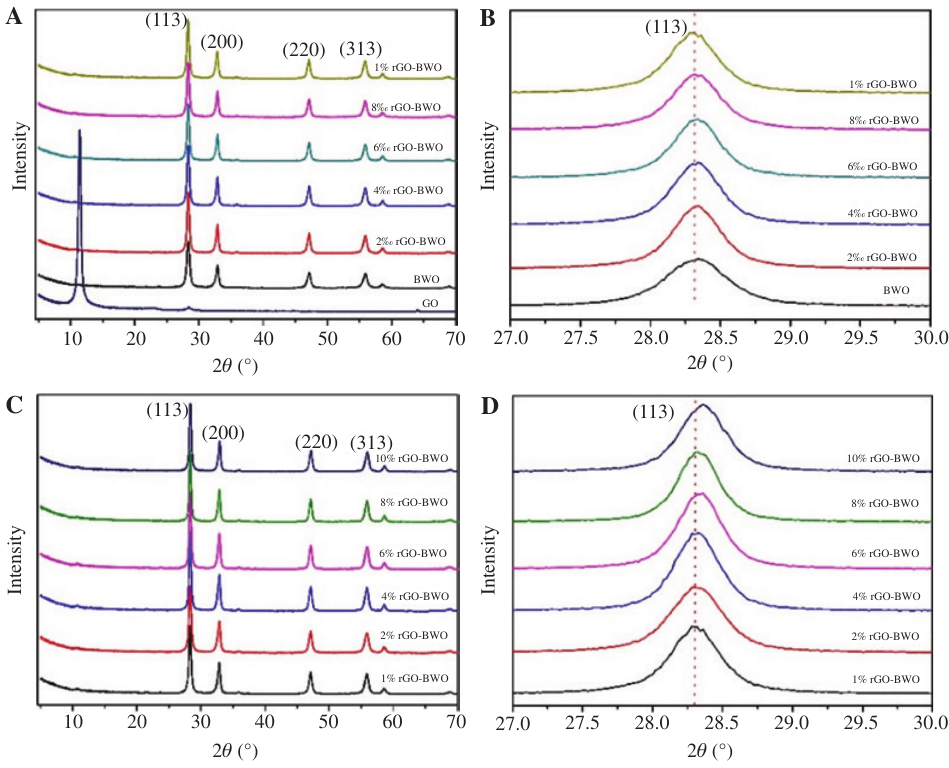
= 0), R = 2‰, 4‰, 6‰, values: (A) GO, BWO (R M M M